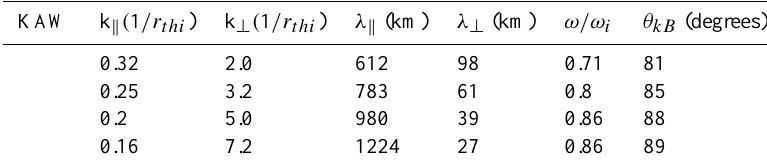
Table 3. Properties of Kinetic Alfv´en waves (KAW) when damping becomes 20% of the real frequency (calculated from WHAMP model with Maxwellian electron and proton species with B =60nT). Columns list parallel and perpendicular wave numbers and wave lengths, real frequency and wave propagation angle with respect to magnetic field. Ion cyclotron radius, r thi , used here is 31km.